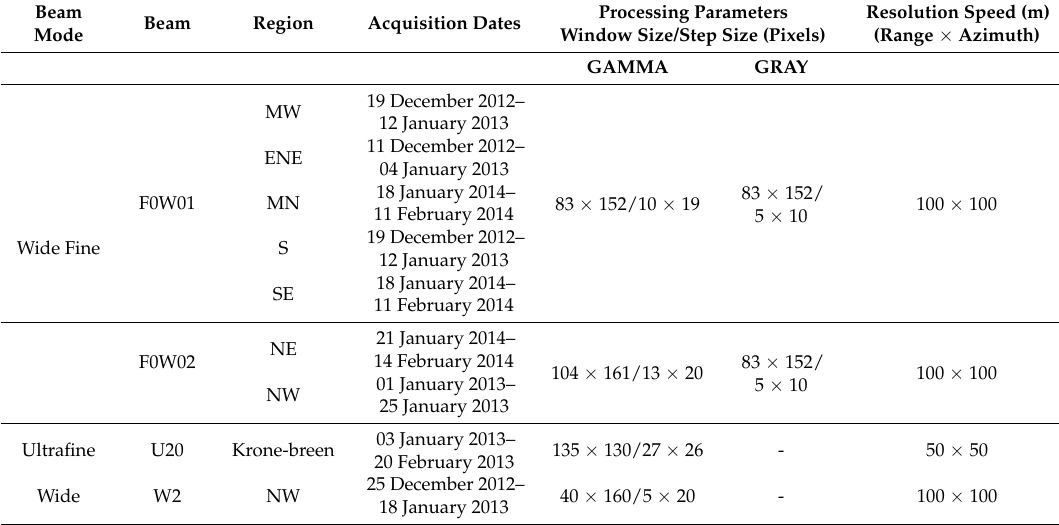
Table 2. Description of the dataset and processing parameters used in this study for different regions: mid-west (MW), east-northeast (ENE), mid-north (MN), south (S), southeast (SE), northeast (NE), northwest (NW) and